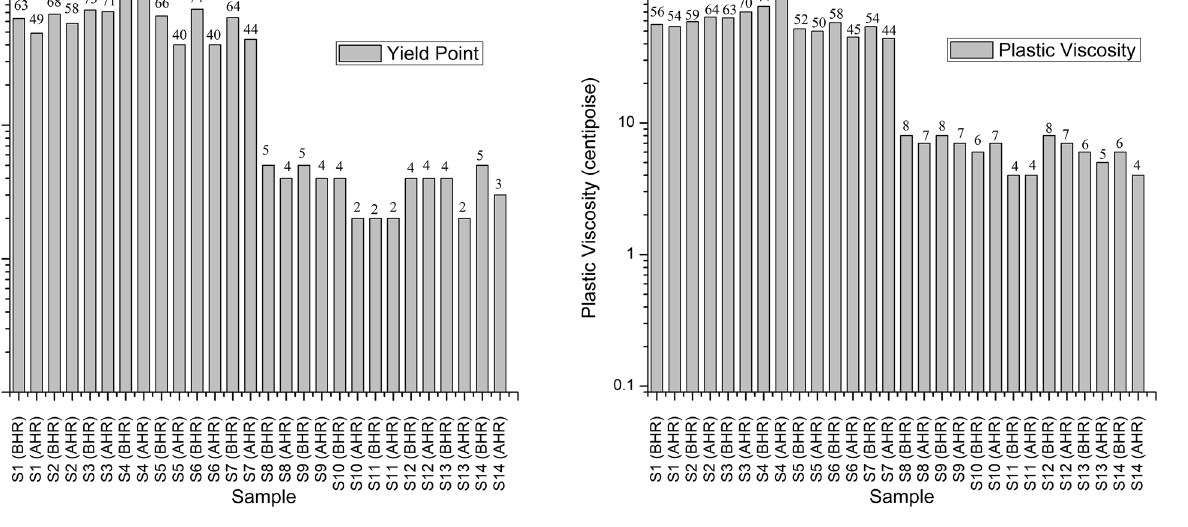
Fig. 3 Yield point of all the prepared drilling fluid samples Fig. 4 Plastic viscosity of all the prepared drilling fluid